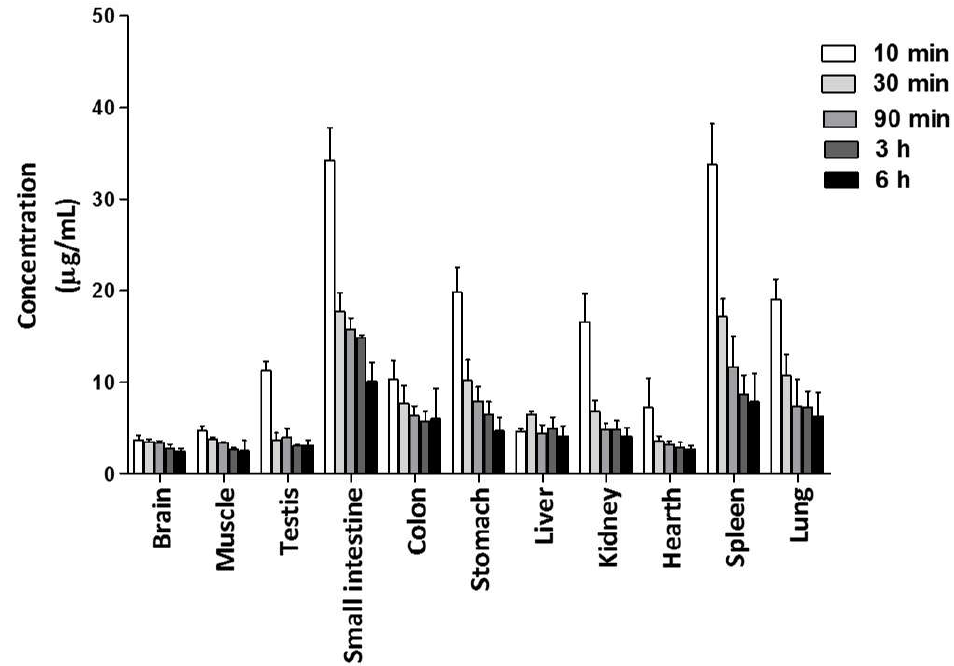
Figure 5. Concentration of C1 in the distinct tissues of rats, evaluated at 10, 30, 60, 90, 180, and 360 min after administering a single p.o. dose (100 mg/dL) of the compound (mean ± SD, n = 3).